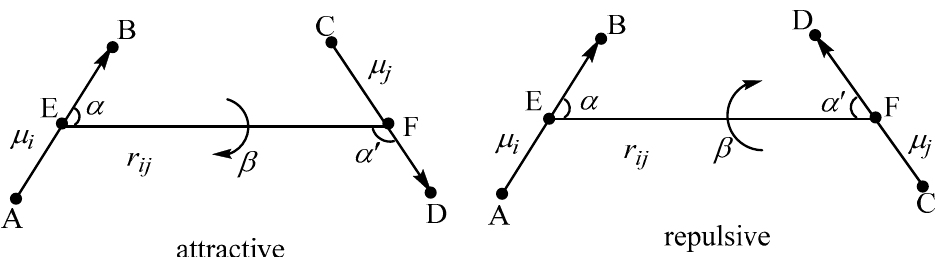
Figure 1. The attractive and repulsive interacting dipoles. Atom A forms a polar chemical bond A-B with atom B; atom C forms another polar chemical bond C-D with atom D. The two polar bonds A-B and C-D are taken as two bond dipoles whose dipole moments are represented by µ i and µ j . E and F are the mid-points of the bonds A-B and C-D, respectively. r ij is the distance between the two mid-points E and F. α and α ’ are the angles between the line EF and the positive direction of the bond dipole. The β is the dihedral angle between the two planes BEF and EFD.